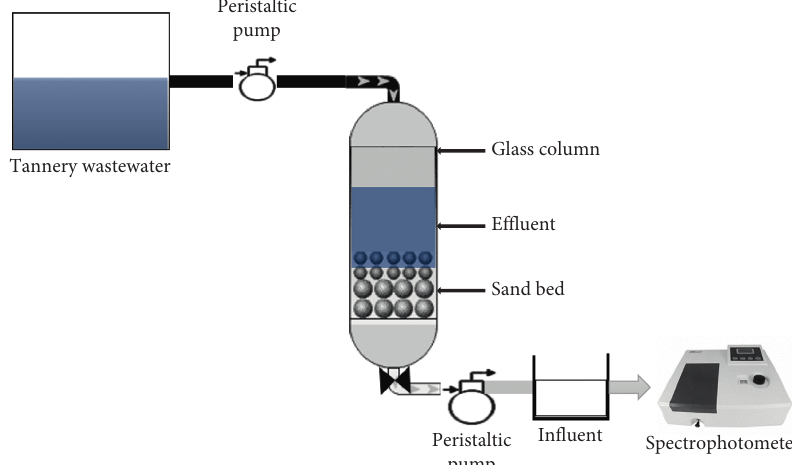
Figure 1: Experimental